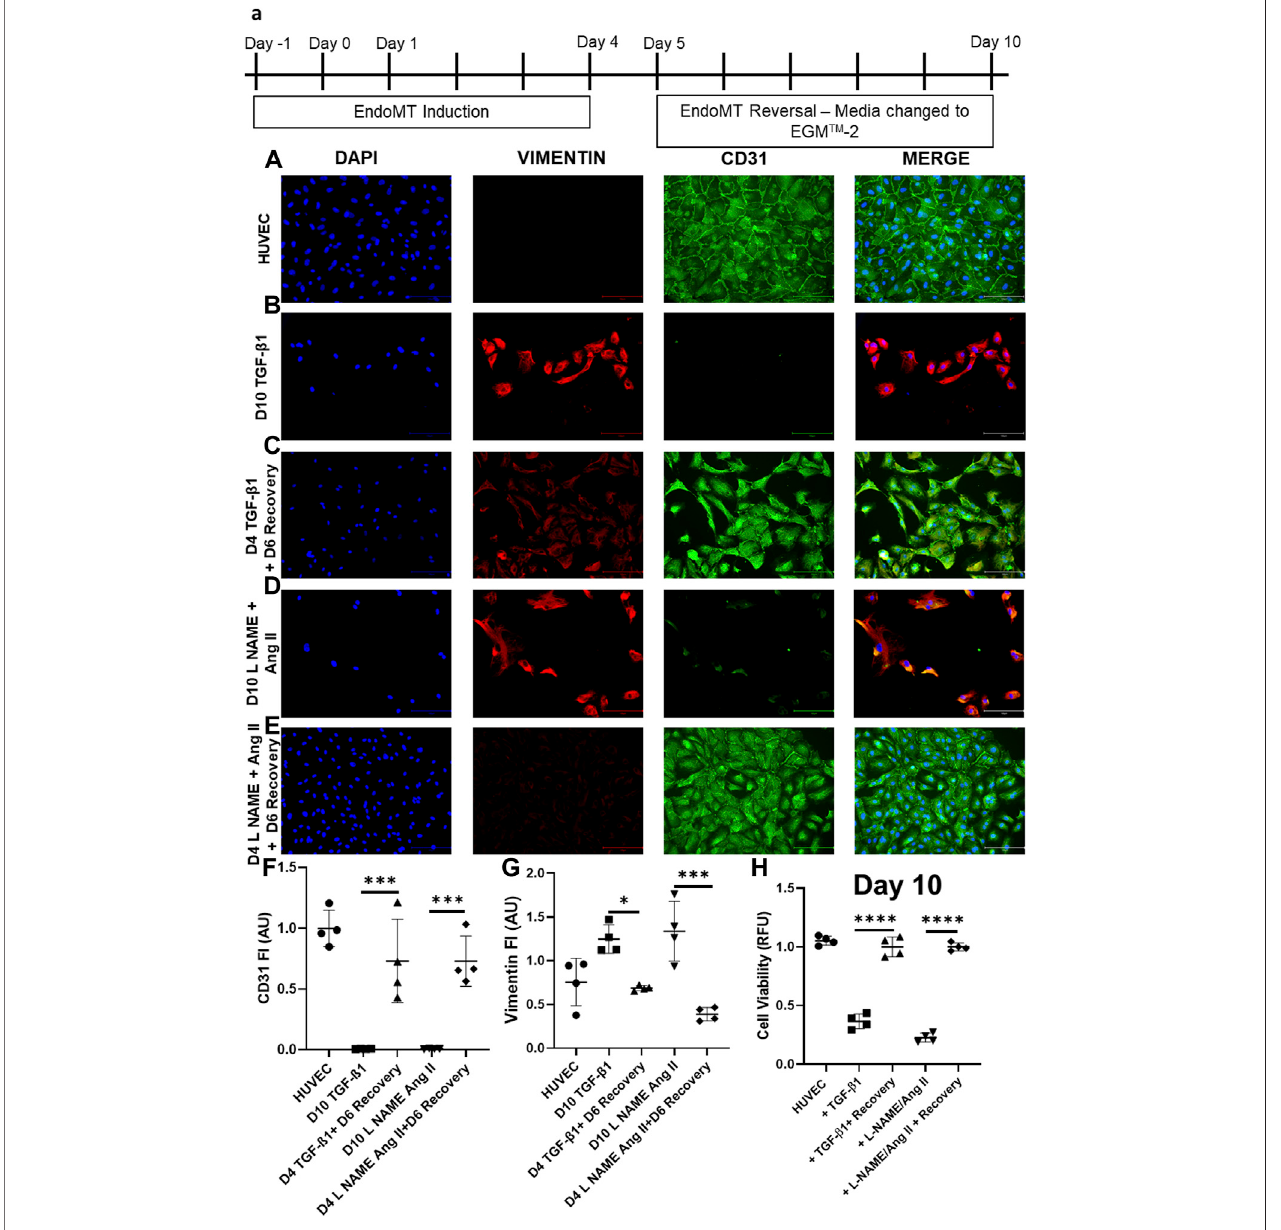
FIGURE 3 | EndoMT is reversible in HUVECs when TGF- β 1 or L-NAME + Ang II stress is removed. (A) Representative scheme for EndoMT and its reversal. Representative images of immuno fl uorescent stained cells for CD31, Vimentin, and DAPI in (A) HUVEC-No treatment, (B) HUVEC treated with TGF- β 1 for 4 days (C) HUVECs treated with TGF- β 1 for 4 days followed by 6 days culture in complete EGMTM-2 medium (D) HUVEC treated with L-NAME + Ang II for 4 days (E) HUVECs treated with L-NAME + Ang II for 4 days followed by 6 days culture in complete EGMTM-2 medium; Scale bar: 150 µm (F,G) Fluorescent intensity of CD31 and Vimentin stained cells in panel (A – E) calculated with Image J ( n = 4); Data presented as ×20 microscopic fi eld measurements. (H) Cell viability was measured using the AlamarBlue assay on day 10 of EndoMT and day 6 of recovery ( n = 4).